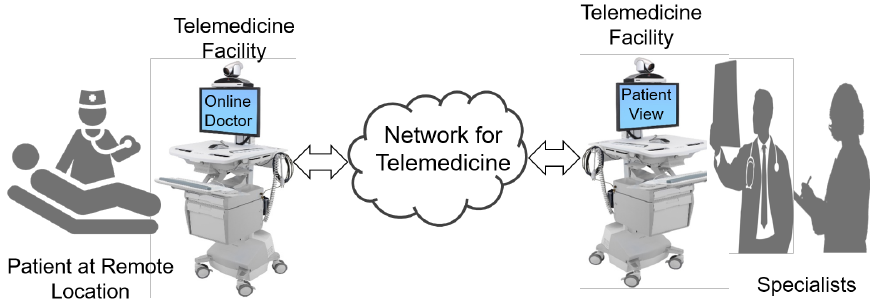
Figure 4. A general architecture of telemedicine with two